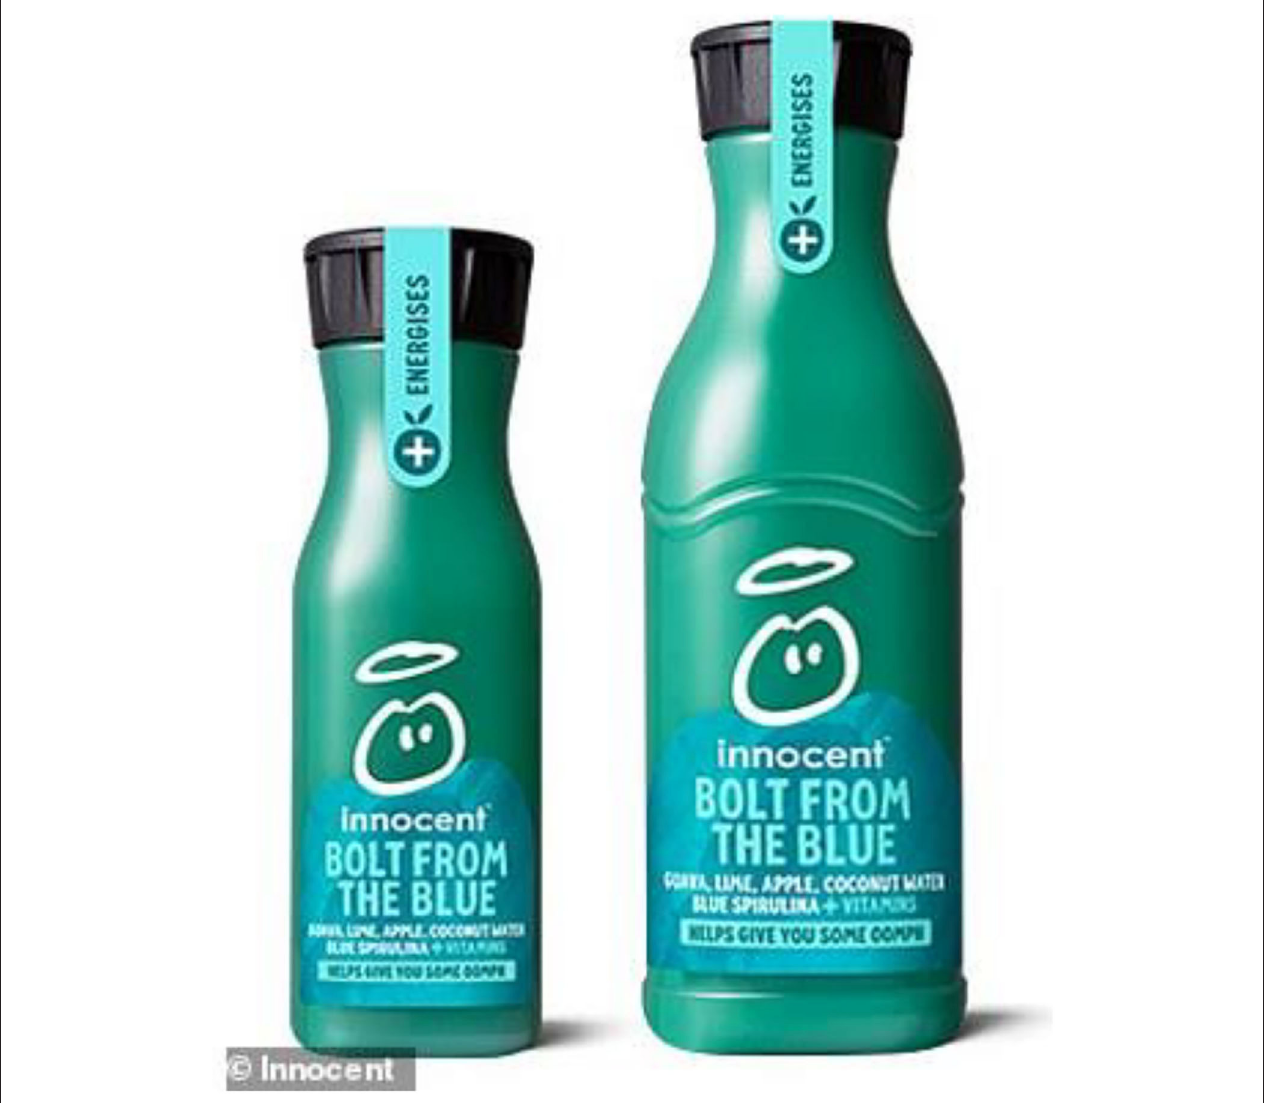
FIGURE 6 | Innocent Drinks launched their Bolt from the Blue in 2018. It has been one of the companies most successful new product launches ever. Who says that blue-colored food and drink products would never sell? Though some have argued the drink is more green than blue (see Jewell, 2019) (Copyright Innocent